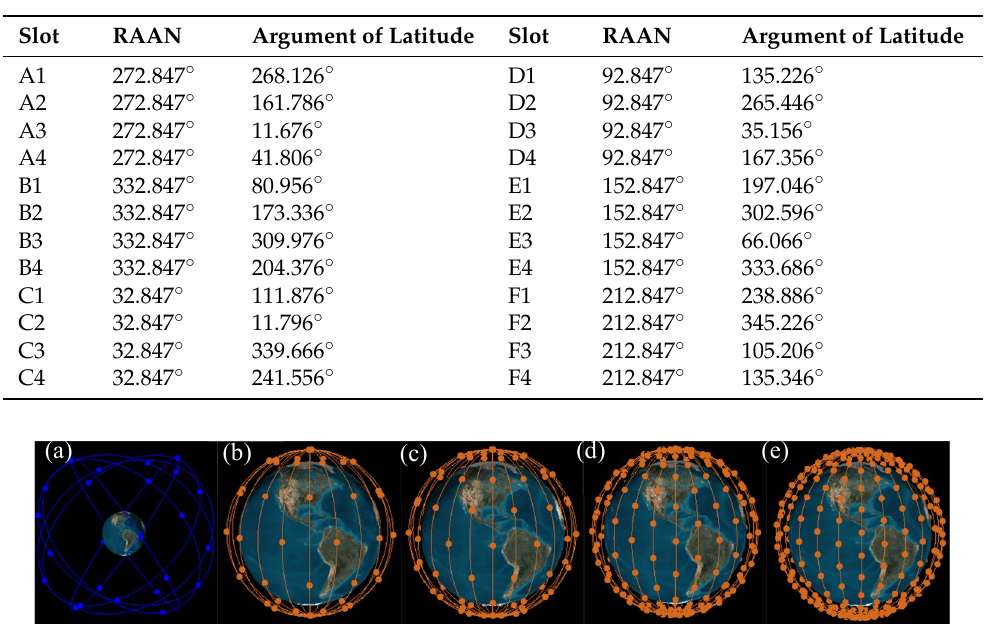
Table 2. Slot assignments of the nominal GPS constellation. RAAN: Right Ascension of the Ascending Node.